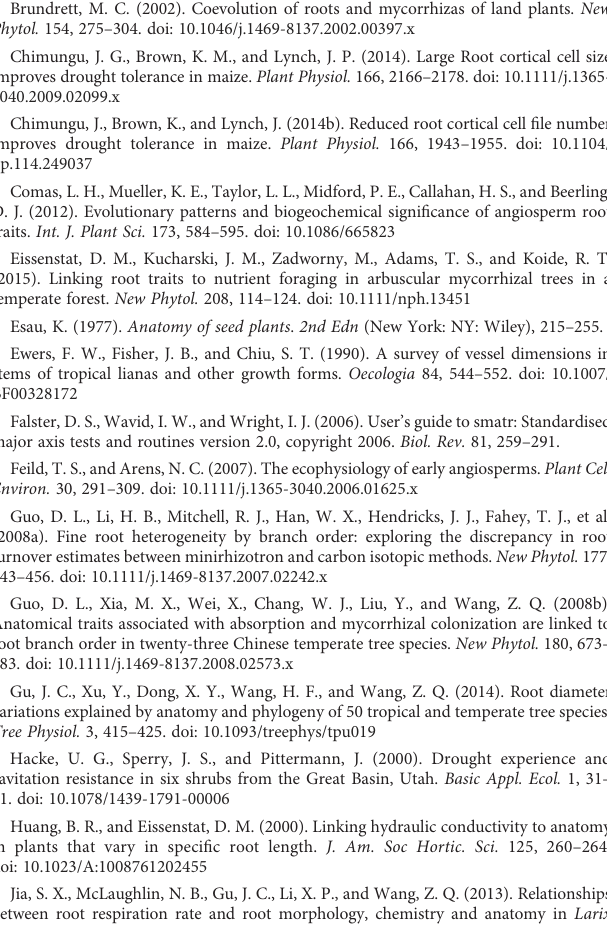
SUPPLEMENTARY FIGURE 1 Relationships among the ratio of unilateral cortex thickness to stele radius (CSR) and root anatomical, morphological and tissue chemical traits among three angiosperm and three gymnosperm tree species ( n = 6). CSR, cortical thickness to stele radius ratio; RD, root diameter; SRL, speci fi c root length; TD, tissue density; NCPS, number of conduits per stele; MCD, mean conduit diameter; TCAC, total cross-sectional area of conduits; MDCC, mean diameter of cortical cell; NCCL, number of cortical cell layer; CAC, Cross-sectional area of cortex; NC, N concentration; CC, C concentration; CNR, C:N